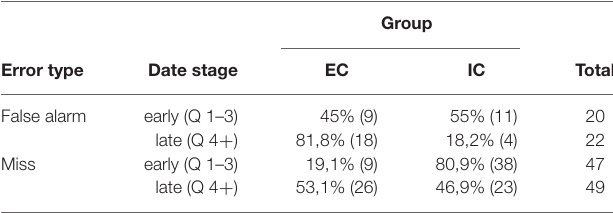
TABLE 1 | Misses and false alarms committed by both groups in the early (questions 1–3) and late (questions 4 + ) stages of